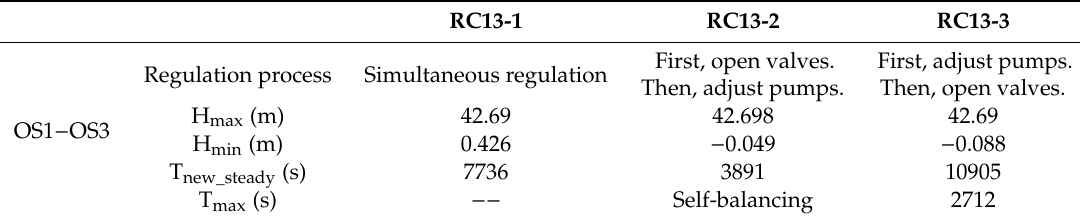
Table 8. The transient processes of the steady-state working conditions for switching from OS1 to OS3. RC13-1 RC13-2 RC13-3 First, open valves. First, adjust pumps. Regulation process Simultaneous regulation Then, adjust pumps. Then, open valves. OS1 − OS3